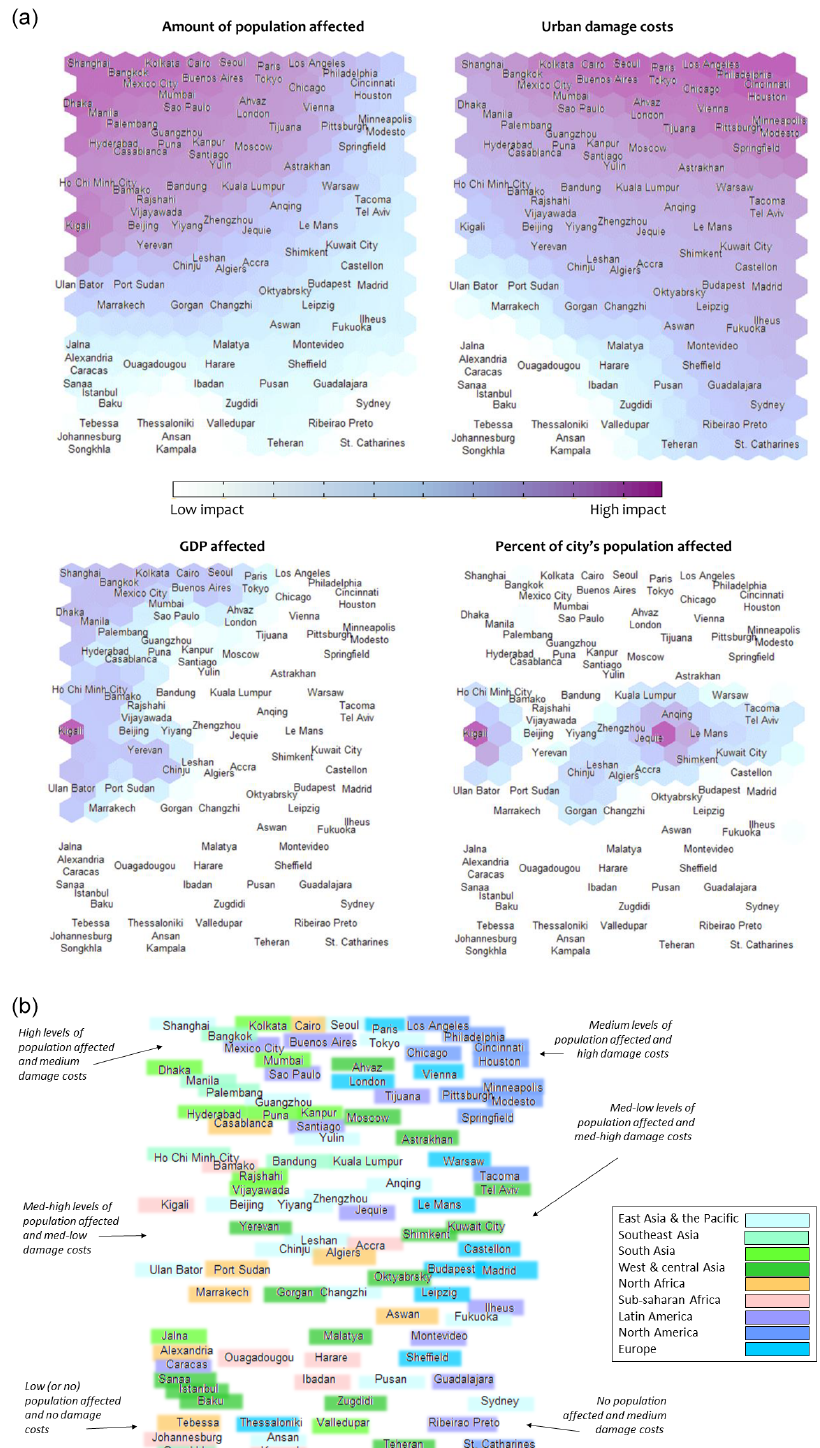
Figure 1. SOM1 – baseline (2010) urban flood conditions. Cities are placed relative to each other based on annual river flooding impacts on population and urban damage costs. (a) The same map is repeated for each of four variables, with colouring indicating low (white) and high (purple) values. (b) The city labels are coloured by region (see Table 1), and characteristic patterns of general areas of the map are annotated. The reader may refer to the online version to zoom in on text if